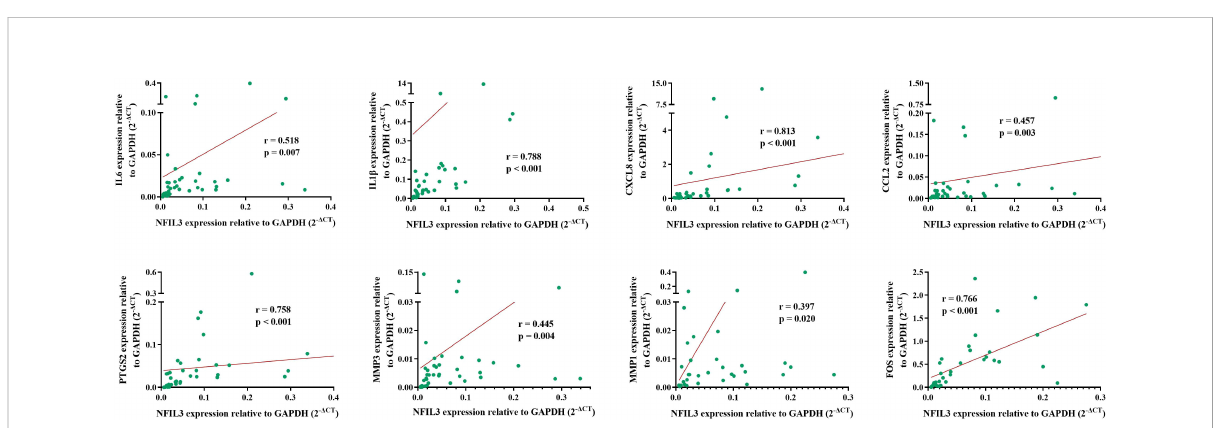
FIGURE 6 Association between NFIL3 and its coexpressed hub genes in RA. The eight hub genes and NFIL3 expression levels were analyzed in RA PBMCs by qRT-PCR and normalized to GAPDH. Spearman ’ s correlation analysis of NFIL3 and IL-6, IL1B, CXCL8, CCL2, PTGS2, MMP3, MMP1, and FOS in RA patients. RA, rheumatoid arthritis; PBMCs, peripheral blood mononuclear